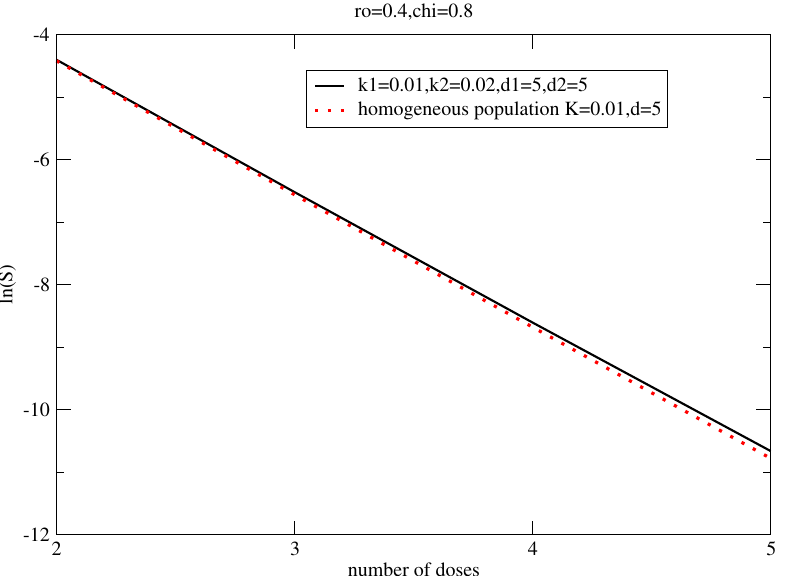
Figure 5. Estimate of the dose-boost with the same parameters of Figure 2 for a hypofraction- ated